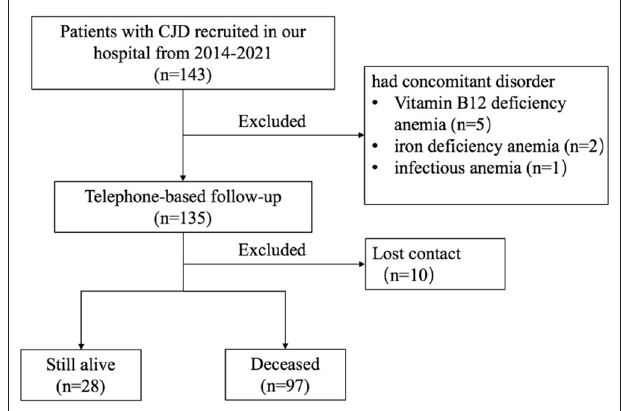
FIGURE 1 | Flow diagram of patient